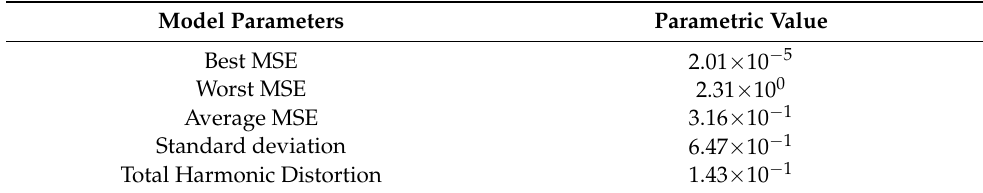
Table 4. Case Study I Parameters after Simulation.